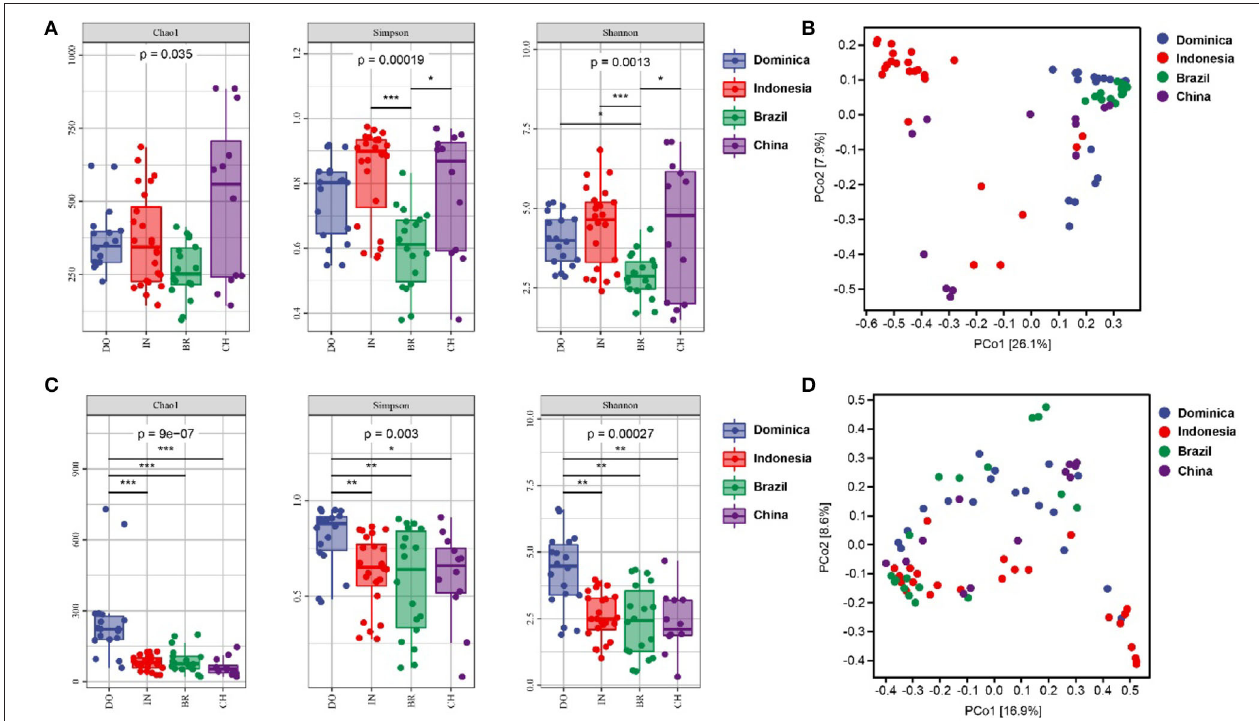
FIGURE 2 | Bacterial alpha diversity (A) and fungal alpha diversity (C) were determined based on the Chao1 index, the Shannon index, and the Simpson index. Bacterial beta diversity (B) and fungal alpha diversity (D) was measured by bray_curtis distance. * < 0.05; ** < 0.01; *** < 0.001.